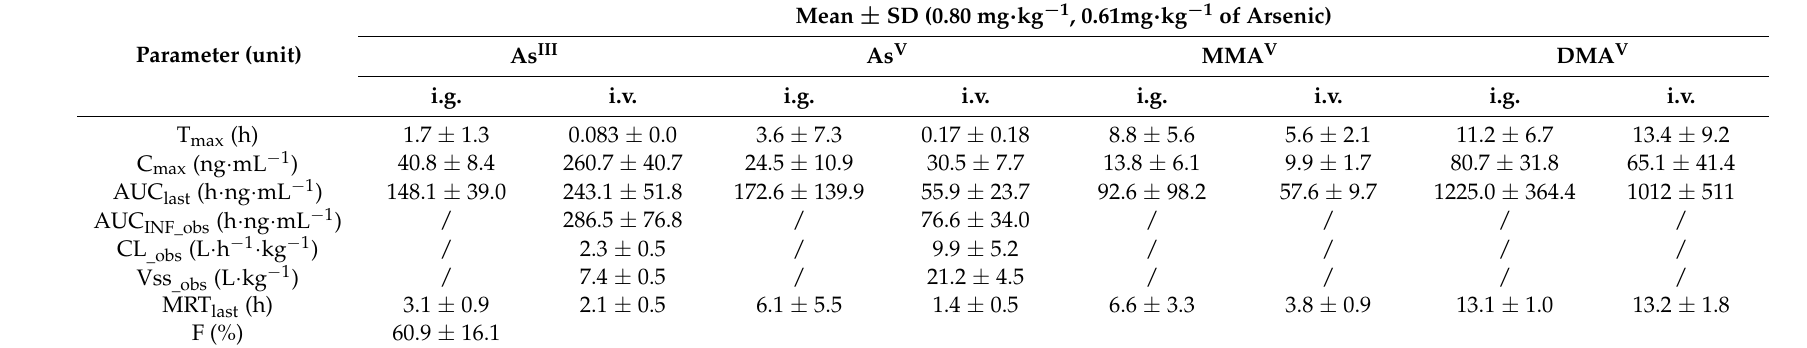
Table 4. Pharmacokinetic parameters of the four arsenic species ( n =